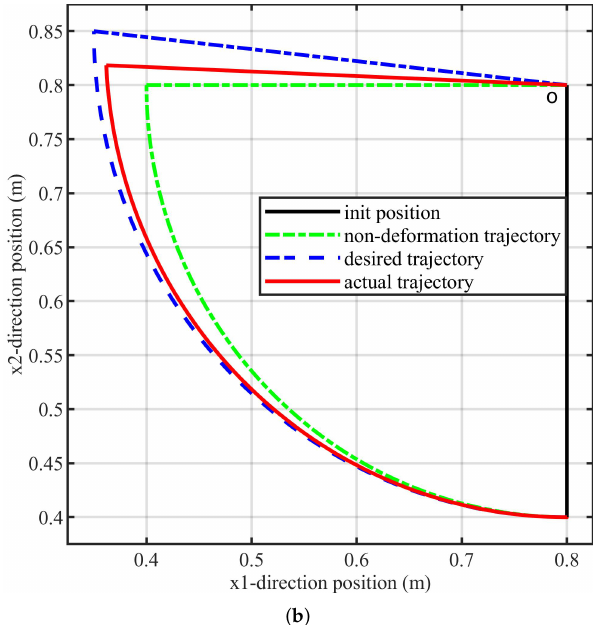
Figure 13. The end-effector’s actual motions with different desired x d in the door-opening task. The actual trajectory of the end effector differs significantly from the desired trajectory due to door’s constraints. ( a ) Simulation results in a quarter-circle arc with a radius of 0.35 m as desired trajectory x d . ( b ) Simulation results in a quarter-circle arc with a radius of 0.45 m as x d